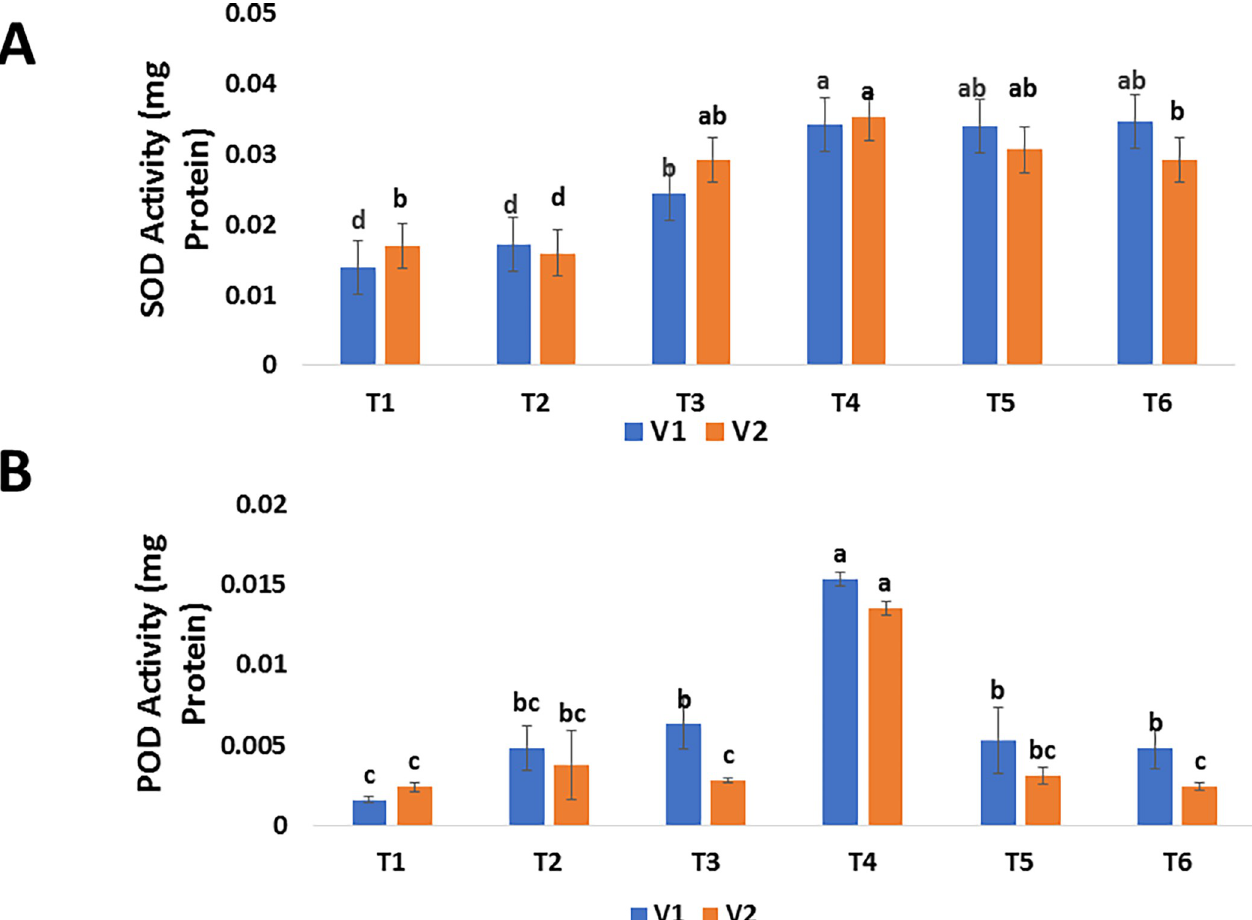
Fig 8. Effect of foliar applications of green synthesized SeNPs on biochemical parameters of Mangifera indica under the stress of mango malformation disease. (A) SOD activity of M . indica in response to different treatments of SeNPs. (B) POD activity of M . indica in response to different treatments of SeNPs.